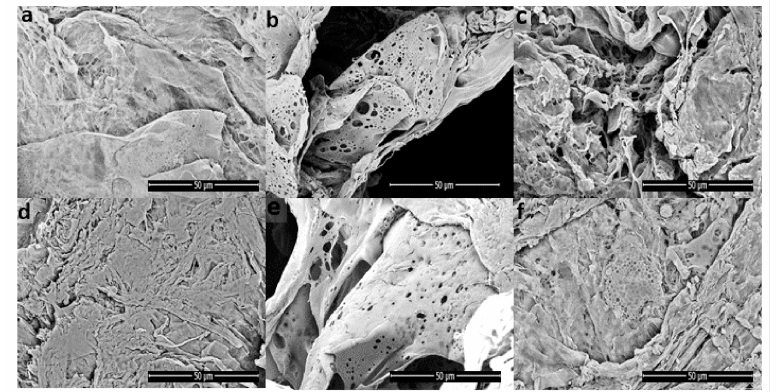
Figure 6. SEM images of the porous bioscaffolds: ( a ) PLA-PVA, ( b ) PLA-PVA/NaCl, ( c ) PLA- PVA/KMnO 4 , ( d ) PLA-PVA (T), ( e ) PLA-PVA/NaCl (T), and ( f ) PLA-PVA/KMnO 4